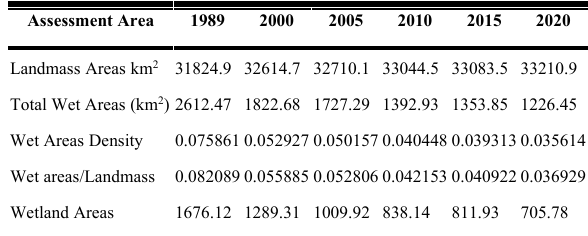
Table 7 . Landscape indicators for wetland sustainability in